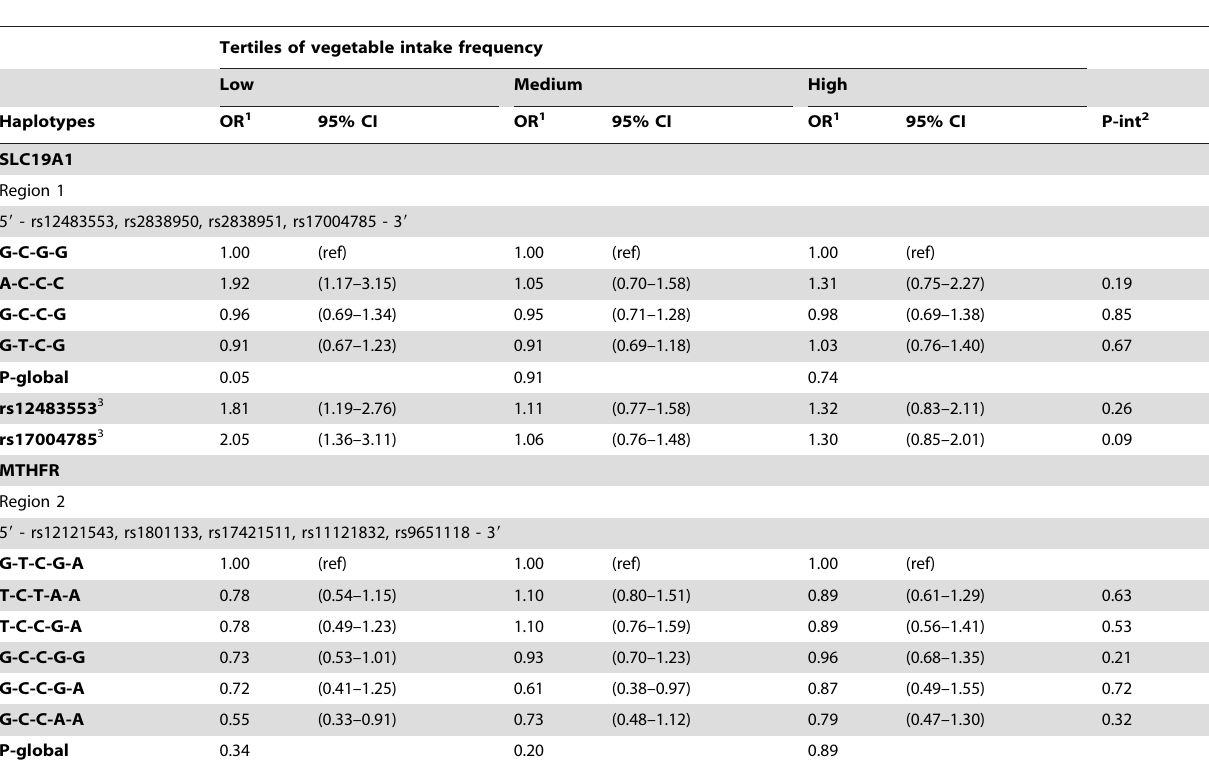
Table 4. Haplotypes in selected one-carbon metabolism genes and risk of renal cell carcinoma, stratified by frequency of vegetable